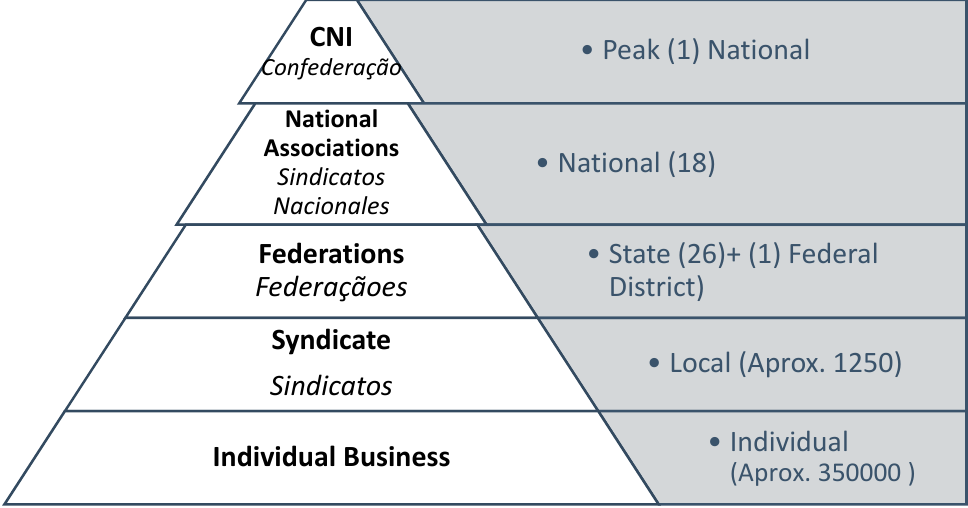
Figure 3. Structure of Government-Mandated Business Associations. CNI—the Confederação Nacional da Indústria.